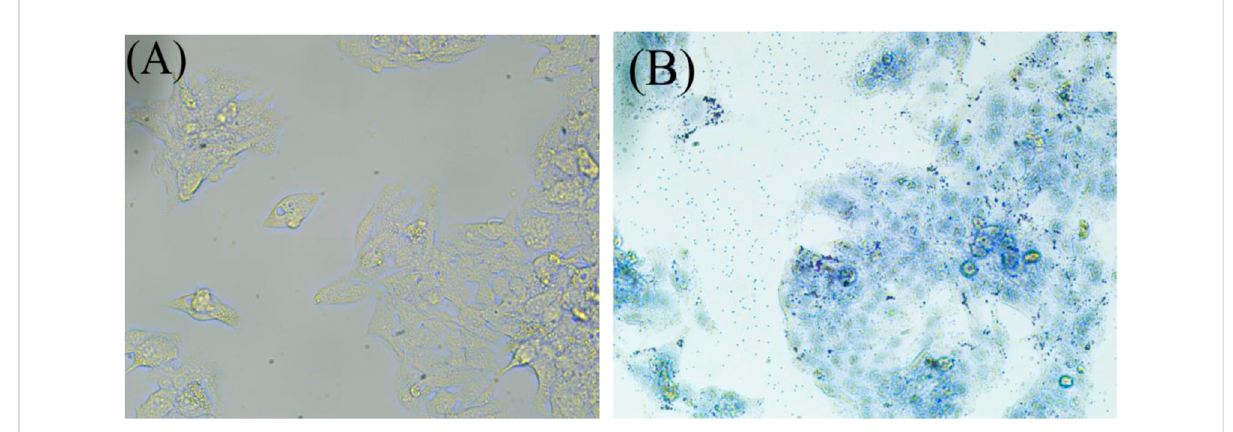
Oil red before staining (A) , and Oil red after staining (B) . The NAFLD cell model was established by oil red O staining. After being stained with oil red O and observed under a microscope with magni fi cation of ×40, obvious lipid droplets were